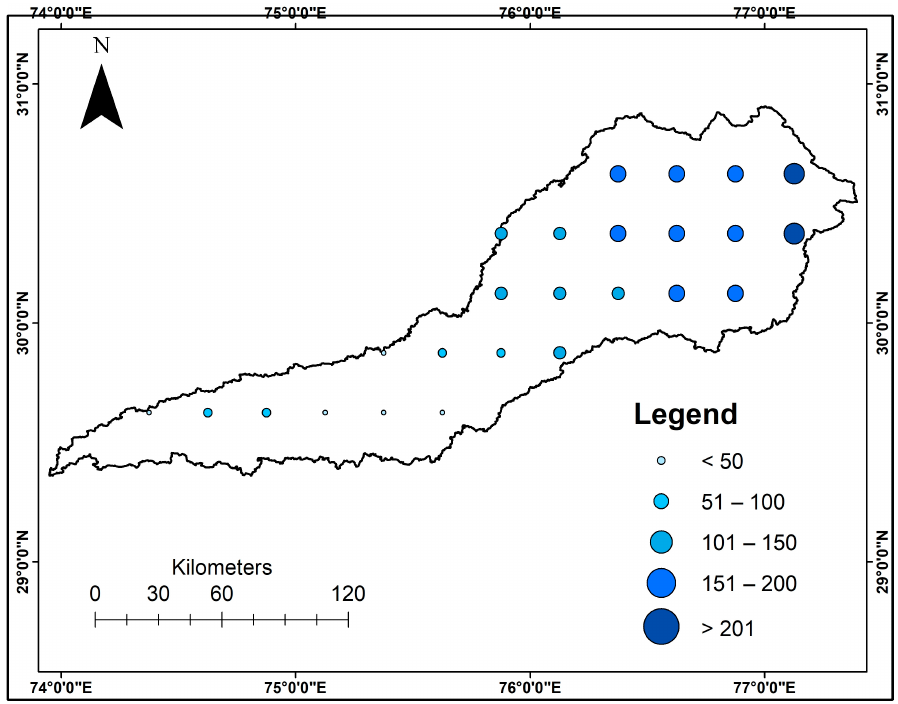
Figure 11. Average rainfall distribution in the study area (Source: chrsdata.eng.uci.edu).